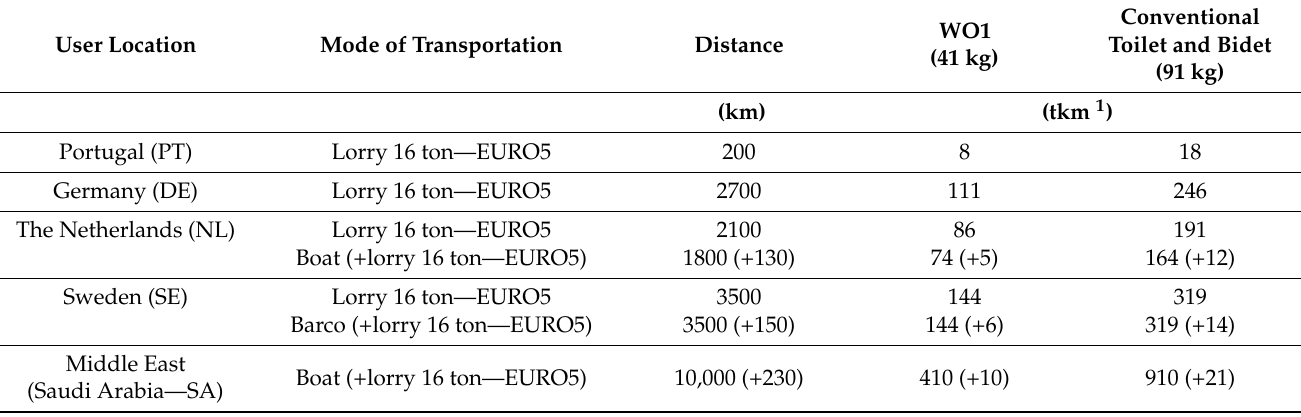
Table 2. Transport characterization for distribution, considering alternative location scenarios for the WashOne toilet with washlet (WO1) and respective conventional system (toilet + bidet). Source: Developed by the authors using data collected by the authors affiliated with OLI and Sanindusa companies and from the